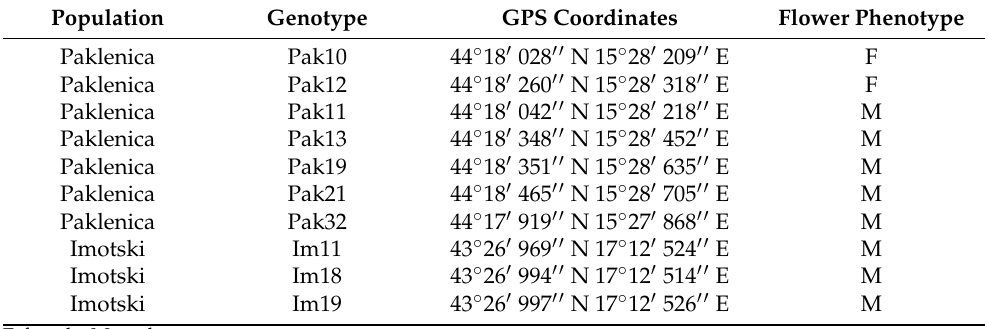
Table 2. V. sylvestris individuals analyzed in this study with information on their population and flower phenotype.